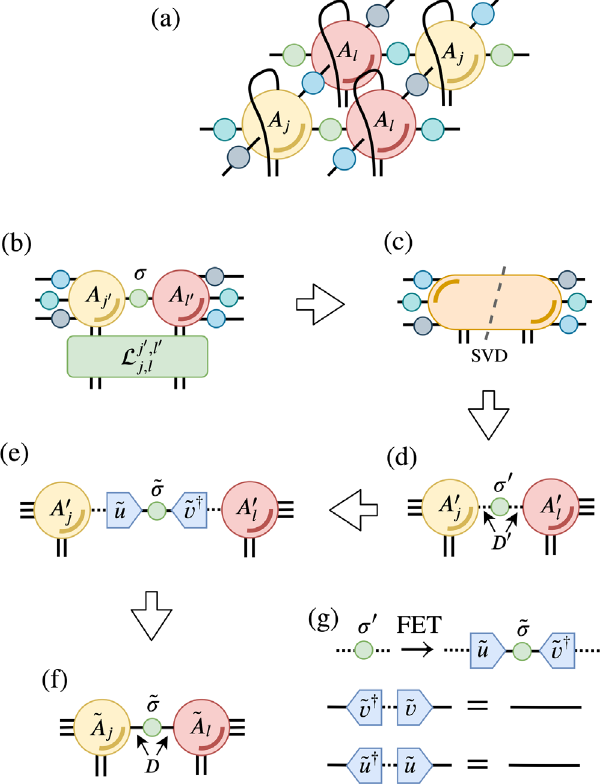
FIG. 2. Main steps in the time evolution algorithm. (a) Vector- ized form of the iPEPO. (b) Contraction of A and A with the j 0 l 0 A dynamical map L . (c) SVD of e τ L A . (d) D 0 singular values of j l relative tolerance greater than ϵ retained in the diagonal bond D 0 matrix σ 0 . (e) Isometries ˜ u and ˜ v , which truncate the enlarged bond from D 0 to D , giving the new bond matrix D . (f) Updated ˜ ˜ A A and . (g) Full environment truncation algorithm to tensors j l find the isometries ˜ u and ˜ v , which maximize the fidelity between truncated and untruncated